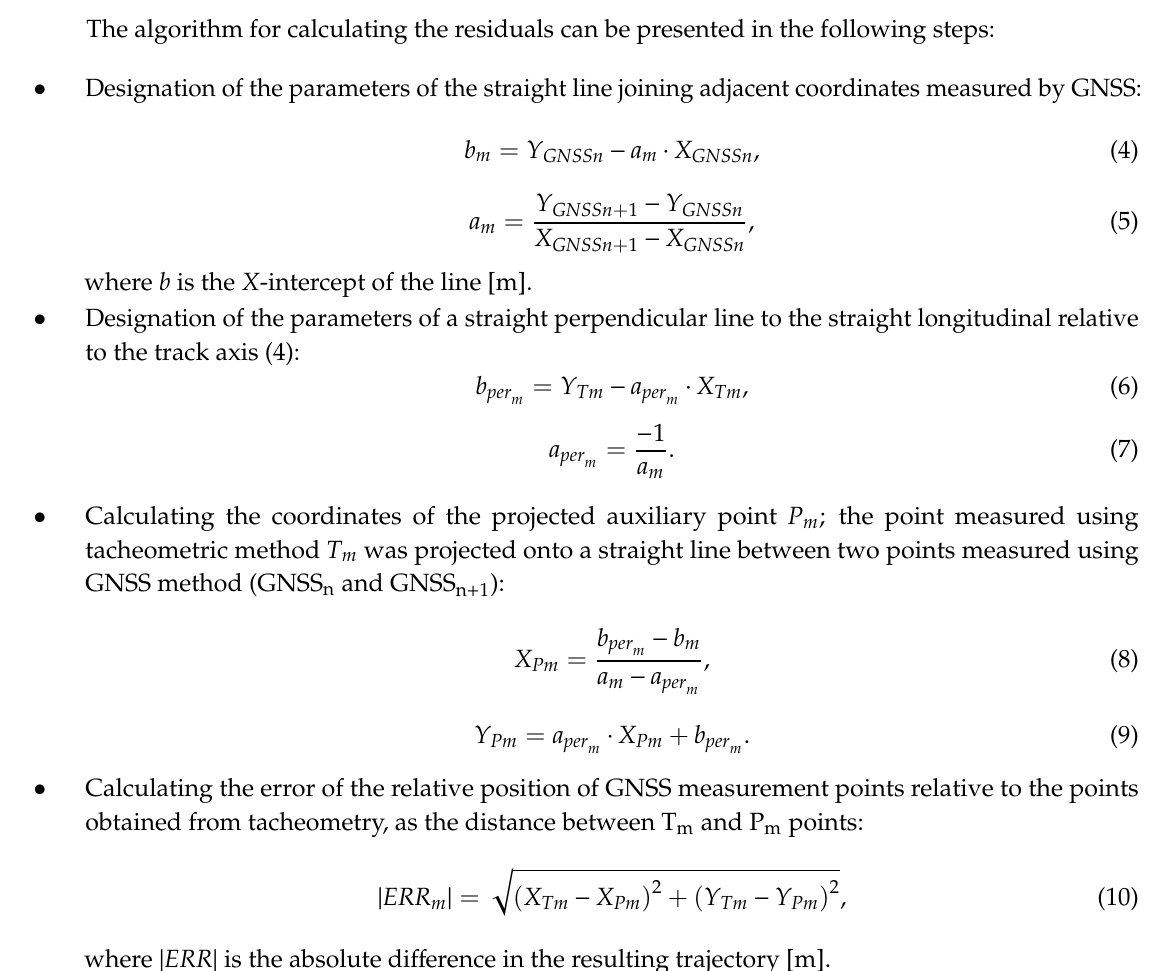
Figure 10. Schematic diagram of the calculation of horizontal absolute residuals between the results of tacheometric measurement and GNSS.